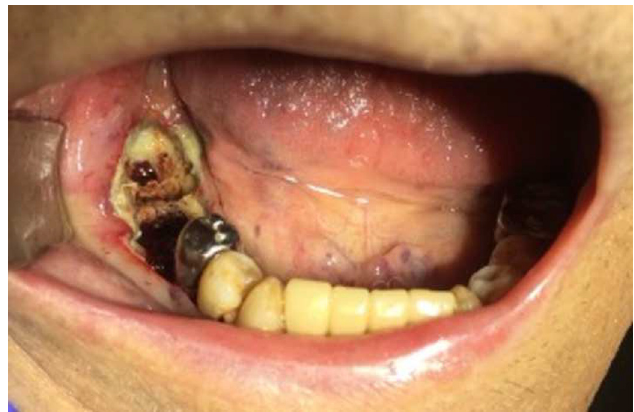
Fig. 1. Post-extraction intraoral view.